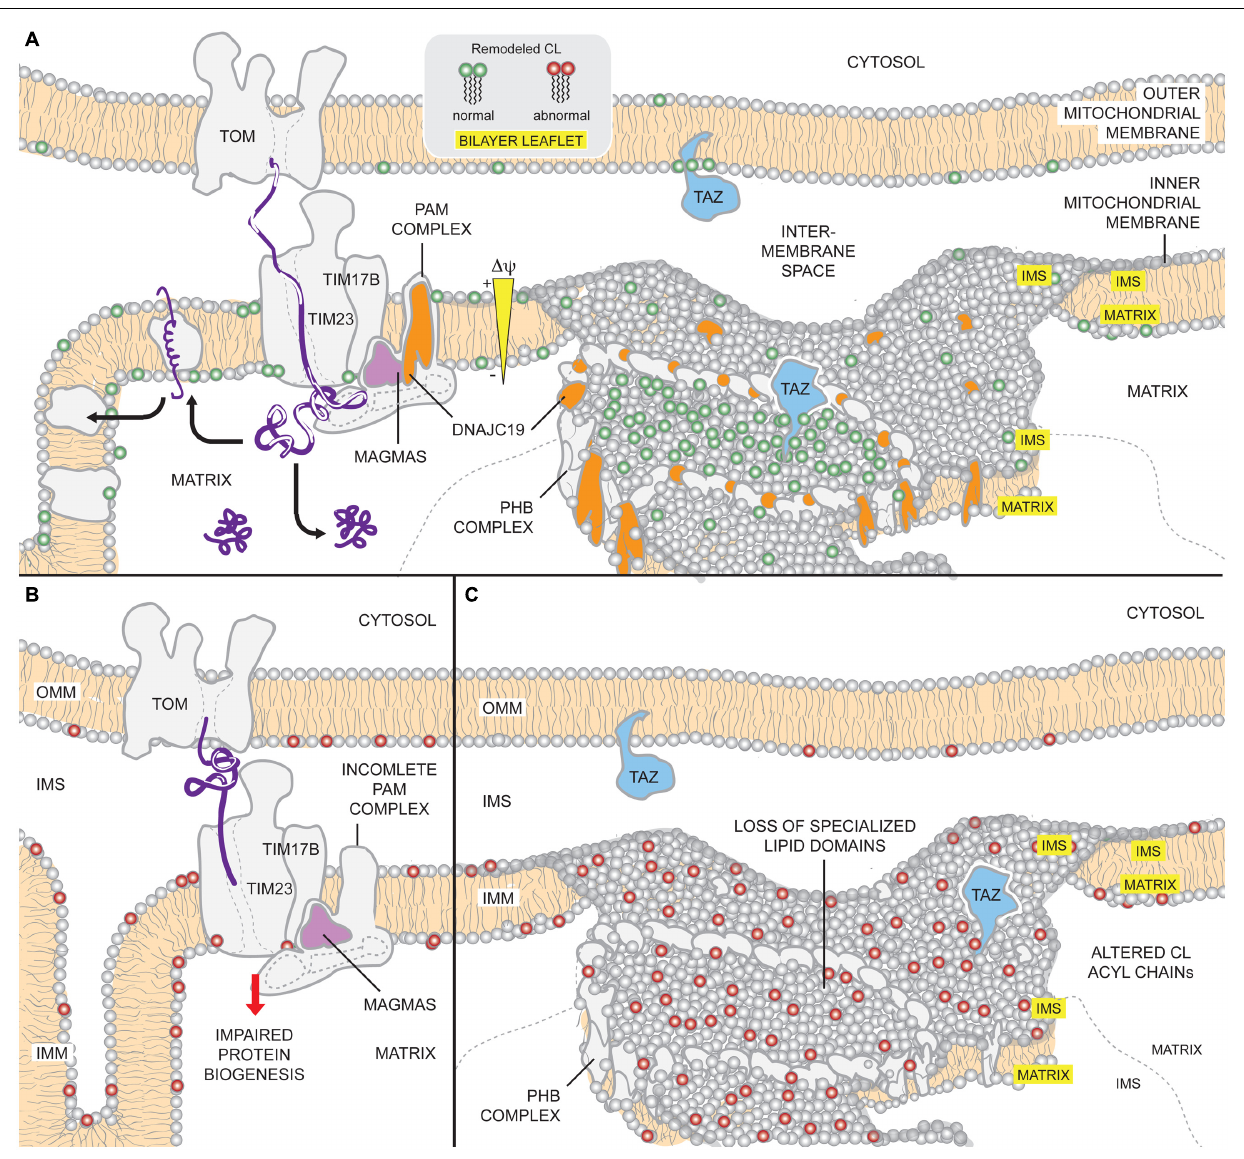
remodeling (green). Thus, DNAJC19 may participate in both mitochondrial presequence protein import as well as formation of membrane domains that are important for TAZ-based CL remodeling. (B) In the absence of DNAJC19, the ability of the TIM23 machinery to import proteins across the IMM may be compromised. Consequently, the biogenesis of mitochondrial proteins, such as subunits of respiratory complexes, may be reduced. (C) Further, loss of DNAJC19 prevents the PHB complex-based generation of privileged membrane domains. In the absence of such domains, TAZ remodeling, which may still occur, lacks specificity (red). For clarity, not all components of the TOM, TIM, and PAM complexes are